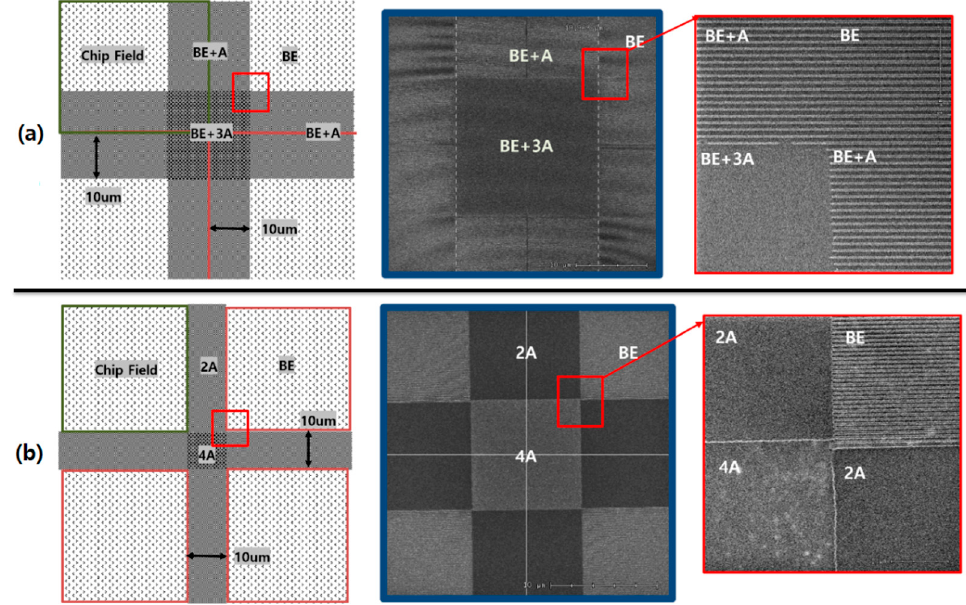
Figure 1. Chip field (shot field) layout for stitching and the photoresist CD according to the number of repetitions of the LFE ( a ) when the shot field interval is set to zero and ( b ) the shot field interval is 10 μ m. There are 50 nm patterns of L/S ratio of 1:1 in chip field.